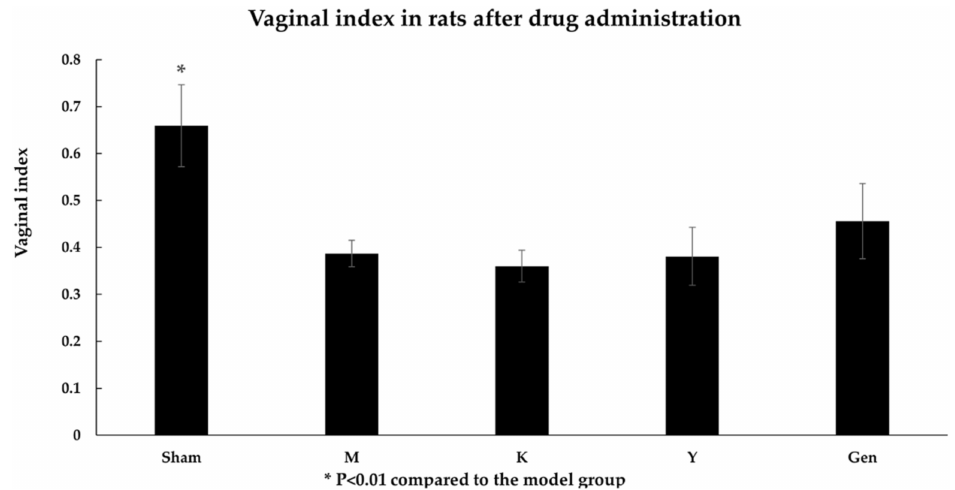
Figure 5. The vaginal index of the rats was significantly lower in the M group than in the Sham group and improved in the Gen group. * p < 0.01 compared to the model group.